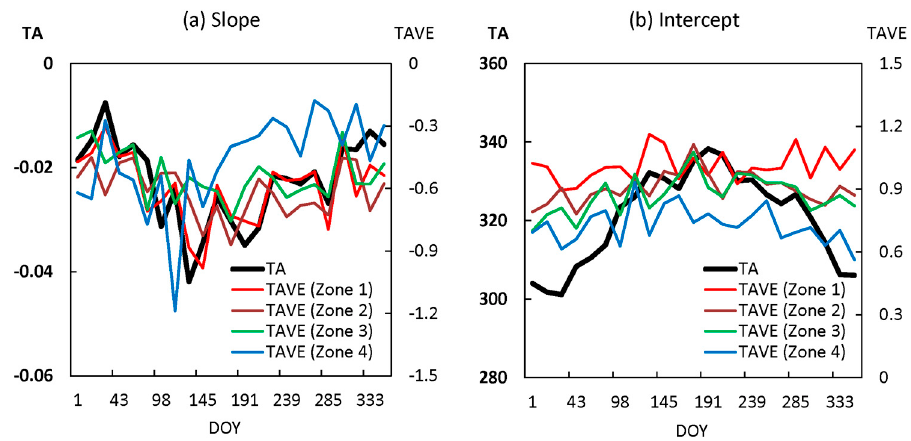
Figure 8. Comparison of dry edges identified by TAVE and TA over 2009: ( a ) the slope and ( b ) the